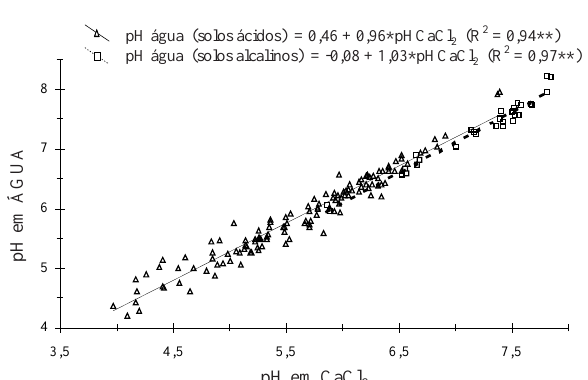
Figura 2. Relação entre o pH em CaCl água em solos ácidos, tratados com composto de lixo, na presença ou ausência de calcário dolomítico e adubos minerais, e em solos alcalinos, em que o calcário foi substituído por